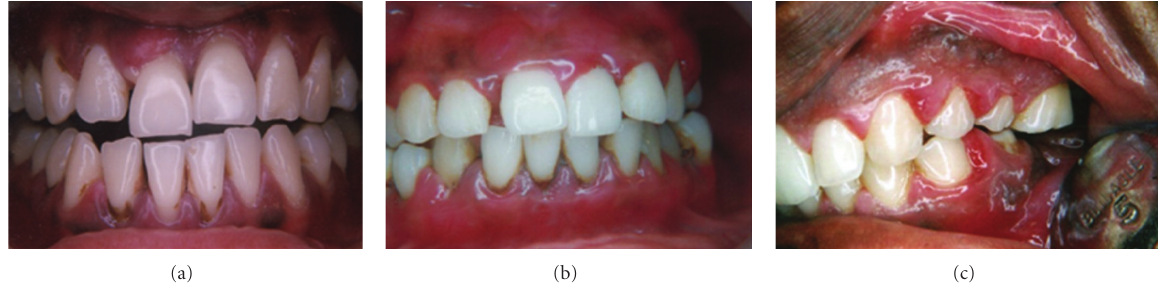
Figure 3: (a)–(c) Features of severe gingival inflammation presented at the stage of active